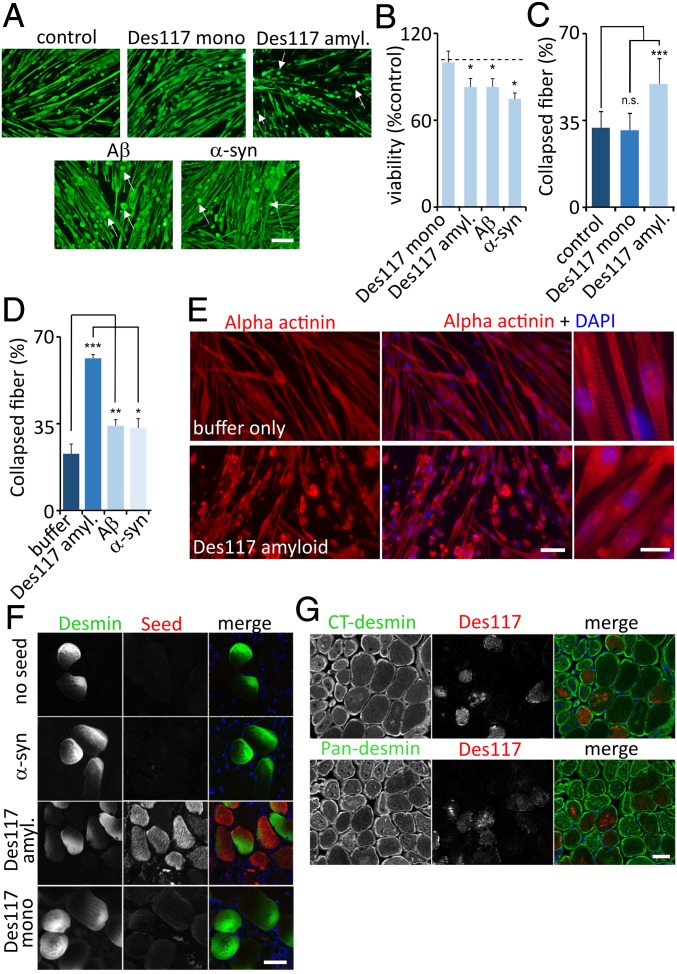
(A) Primary mouse myotubes treated with buffer, des117 monomer, des117 amyloid, or control amyloids (Aβ or α-synuclein) immunostained with an anti-desmin antibody. Arrows denote collapsed myofibers. (B) MTT viability assay of cells in A as a percentage of untreated control cells (dashed line); mean ± SD, n = 12. (C–D) Quantitation of the percentage of collapsed fiber in primary mouse myotubes treated with buffer, des117 monomer, des117 amyloid, Aβ 42 or α-synuclein (n = 10; >1,000 myotubes/condition). (E) Primary myotubes treated with buffer or des117 amyloid and stained with anti α-actinin antibody. Collapsed fibers have diffuse α-actinin staining, as opposed to elongated fibers with sarcomeric structure. (F) Confocal images of cryosections of tibialis anterior muscle electroporated with GFP-desmin and fluorescently labeled α-synuclein fibrils, des117 amyloid or des117 monomer. (G) Confocal images of cryosections of tibialis anterior muscle electroporated with fluorescently labeled des117 amyloid then stained with an antibody recognizing the C terminus or an epitope within the desmin fragment (pan-desmin). Blue is DAPI-stained nuclei. *P < 0.01; **P < 0.001; ***P < 0.0001; n.s., not significant. (Scale bars: A, E, Left, F, and G, 50 μm; E, Right, 10 μm.)